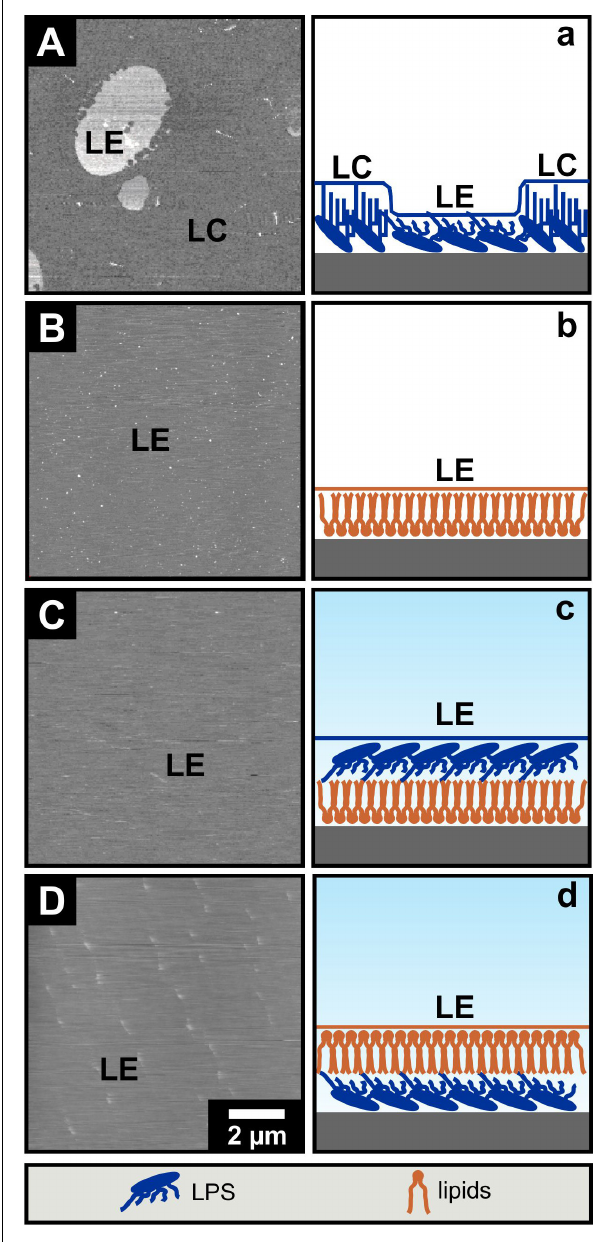
FIGURE 2 | The phase separation of LPS R45 solid supported Langmuir-Blodgett monolayers is not maintained in asymmetric bilayers. Solid supported Langmuir-Blodgett monolayers (A,B) were imaged by AFM in air while imaging of Langmuir-Blodgett bilayers (C,D) was conducted in buffer. (A,a) LPS R45 monolayer; liquid expanded (LE) domains appear higher compared to the liquid condensed (LC) domains in the attractive regime of the AFM AC-mode; (B,b) PL (PE:PG:CL; 81:17:2; w/w/w) monolayer; (C,c) LPS R45/PL bilayer with the PL adsorbed on the solid support and the LPS R45 oriented to the buffer; and (D,d) PL/LPS R45 bilayer with the LPS adsorbed on the solid support and the PL oriented to the buffer. Only the LPS R45 monolayer showed a phase separation. Monolayer formation, Langmuir-Blodgett transfer and AFM imaging were performed in 100 mM KCl, 5 mM MgCl 2 , 5 mM HEPES buffer at pH 7.0 and T = 21 ◦ C. Lateral pressure of the monolayer during transfer to the mica was p = 20 mN/m. AFM height images are shown with a gray scale range of 5